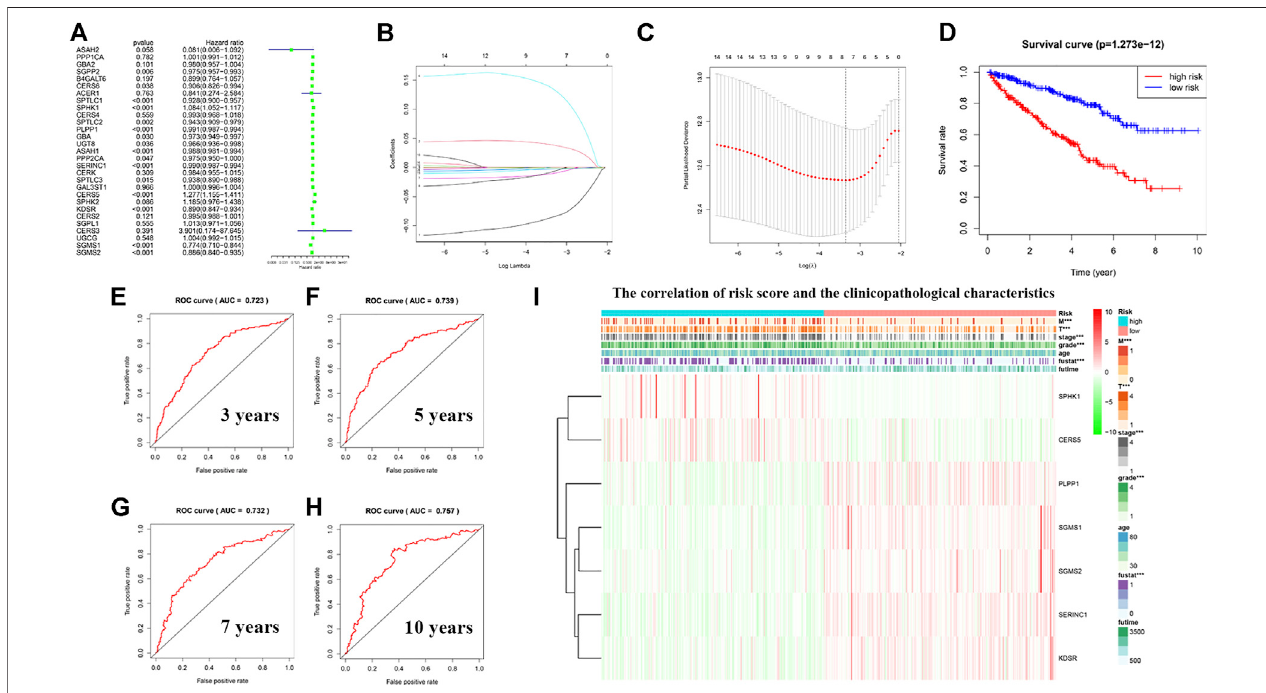
FIGURE 10 | Construction of a risk model using least absolute shrinkage and selection operator (LASSO) Cox regression analysis. (A) The forest plot shows the resulting hazard ratios of 29 sphingolipid pathway genes in KIRC. (B) The LASSO coef fi cient pro fi les of sphingolipid pathway genes in KIRC. (C) The distribution and median value of the risk scores, using LASSO Cox regression analysis to screen out seven genes. (D) Survival curve drawn according to the model. The overall survival rateofpatientsinthehigh-riskgroupwassigni fi cantlylowerthanthatofpatientsinthelow-riskgroup.Redrepresentsthehigh-riskgroup,bluerepresentsthelow- riskgroup. (E – H) ROCcurvesassociatedwith3,5,7,and 10 years (I) Correlationheatmapofriskscoresand clinicopathologicalcharacteristics.Theredbarrepresents gene upregulation, and the green bar represents gene downregulation (*** p < 0.001).